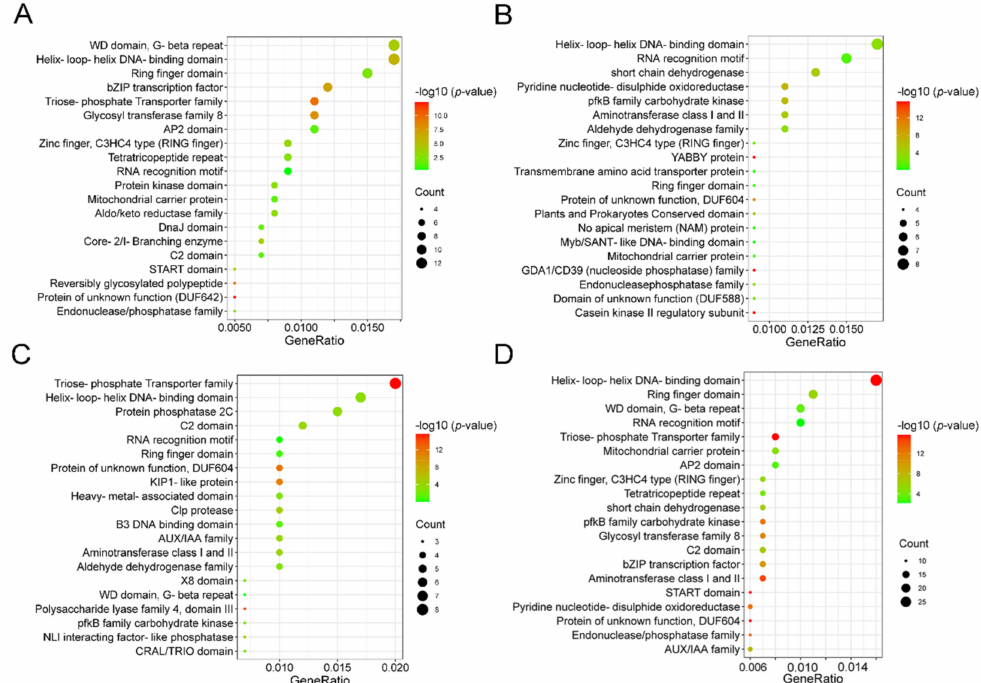
Figure 7. Bubble diagram of domain enrichment for converted genes. ( A ) Enrichment of duplicated gene domains in gene conversion in diploid peanut. The abscissa represents the total percentage of genes containing this domain, the ordinate represents the various domains; the size of the circle represents the number and the color represents the e -value. ( B ) Enrichment of duplicated gene domains in gene conversion in Shitouqi. ( C ) Enrichment of duplicated gene domains in gene conversion in Tifrunner. ( D ) Enrichment of duplicated gene domains in gene conversion in all the different ploidies of